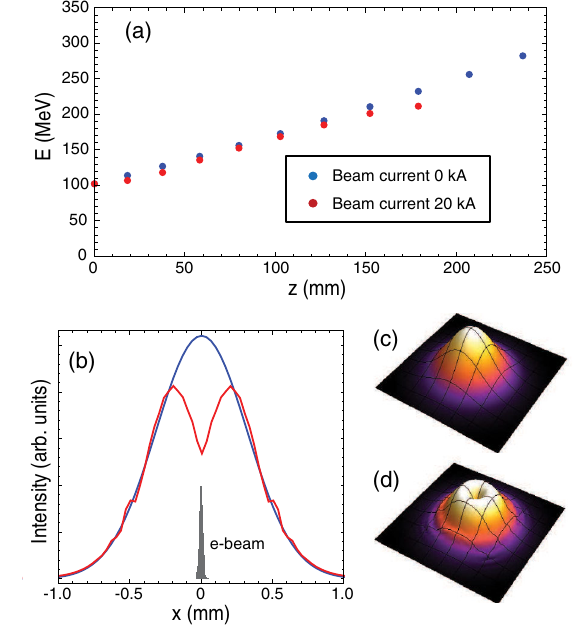
FIG. 13. (a) Mean beam energy vs position along undulator for a 0 kA and 20 kA beam. The 20 kA beam slips from resonance by the 9th undulator period. (b) Laser profiles at period 8 for the 0 kA and 20 kA beams (electron beam distribution shown in gray). (c) Laser intensity profile for the 0 kA beam at the 8th period. (d) Laser intensity profile for the 20 kA beam at the 8th